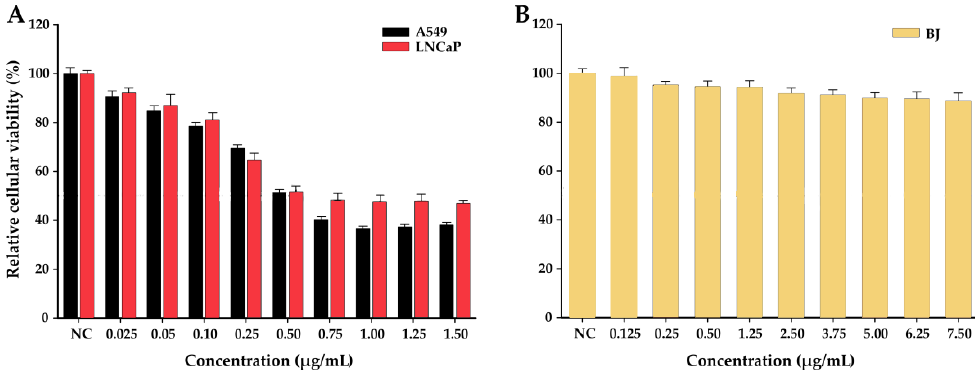
Figure 3. Cytotoxic effect of doxorubicin ( A , B ) after a 24 h exposure on A549, LNCaP and BJ cells. The IC 50 values were calculated for all the compounds towards doxorubicin (Table 9). The results indicated that at all concentrations tested, the type of cells and the compounds tested had a statistically significant contribution to the recorded viability. Table 9. Calculated IC 50 values ( µ g/mL) after exposure of human lung adenocarcinoma (A549), human prostate carcinoma (LNCaP), and human normal foreskin fibroblasts (BJ) to the synthesized compounds ( 5a – d and 6a – d ), for 24